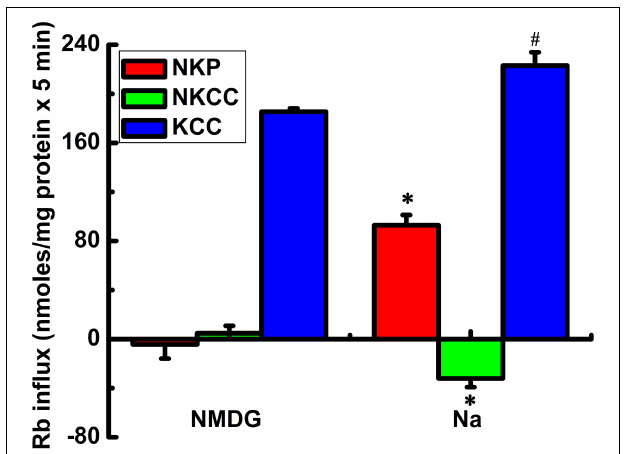
FIGURE 3 | Rb + influx via KCC3, NKCC1, and NKP in Na + and N-methyl-D-glucamine (MDG) medium. Rb + influx through the Na + /K + pump (NKP), NKCC and KCC (red, green, and blue bars, respectively) was calculated as ouabain sensitive; Cl-dependent, bumetanide-sensitive; and Cl-dependent, ouabain and bumetanide-insensitive Rb + influx, respectively. KCC3 AA but not KCC3 WT (results not shown) induction causes a potent increase in flux through KCC3, which is accompanied by inhibition of NKCC and stimulation of NKP. The effects of KCC3 AA induction on NKCC and NKP are abolished when extracellular Na + is replaced with NMDG. n = 6 individual determinations from a single experiment, total number of experiments N = 2 . # p < 0 . 05 ; * p < 0 . 005 , n = 12 , data represent the mean ± SEM values. Two-sample t -test was employed to determine the statistical significance of the differences between Na + and MDG, as indicated.